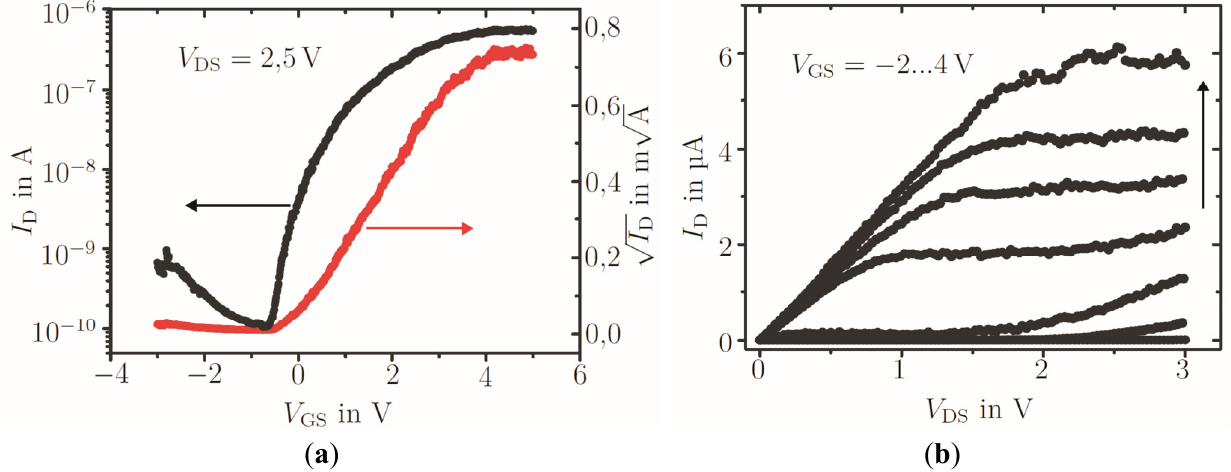
Figure 12. ( a ) Transfer and ( b ) output characteristics of an inverted coplanar single particle TFT integrated using the SWEB technique with ZnO nanoparticle (L = 80 nm, W = 100 µm and t ox = 31 nm). © 2015 IEEE. Reprinted, with permission, from [3].